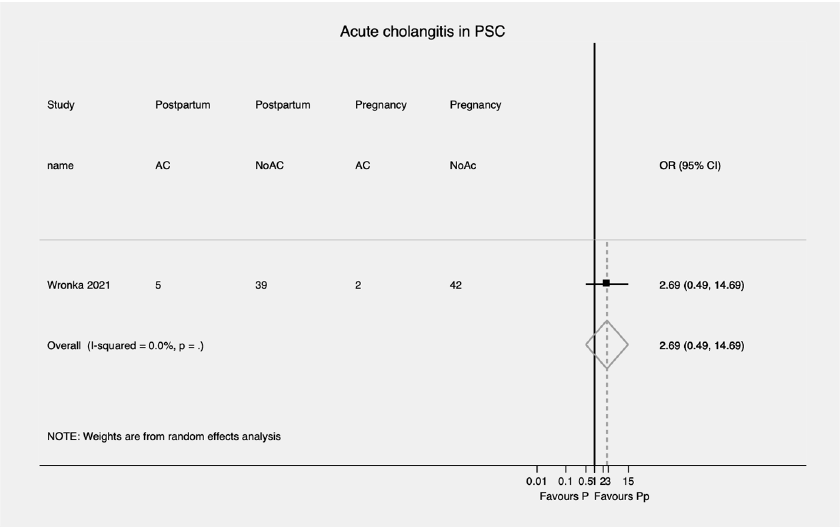
Figure 7. Acute cholangitis during pregnancy and postpartum in PSC. PSC—Primary sclerosing cholangitis; OR—Odds ratio; CI—Confidence interval; AC—Acute cholangitis; Pp—Postpartum;